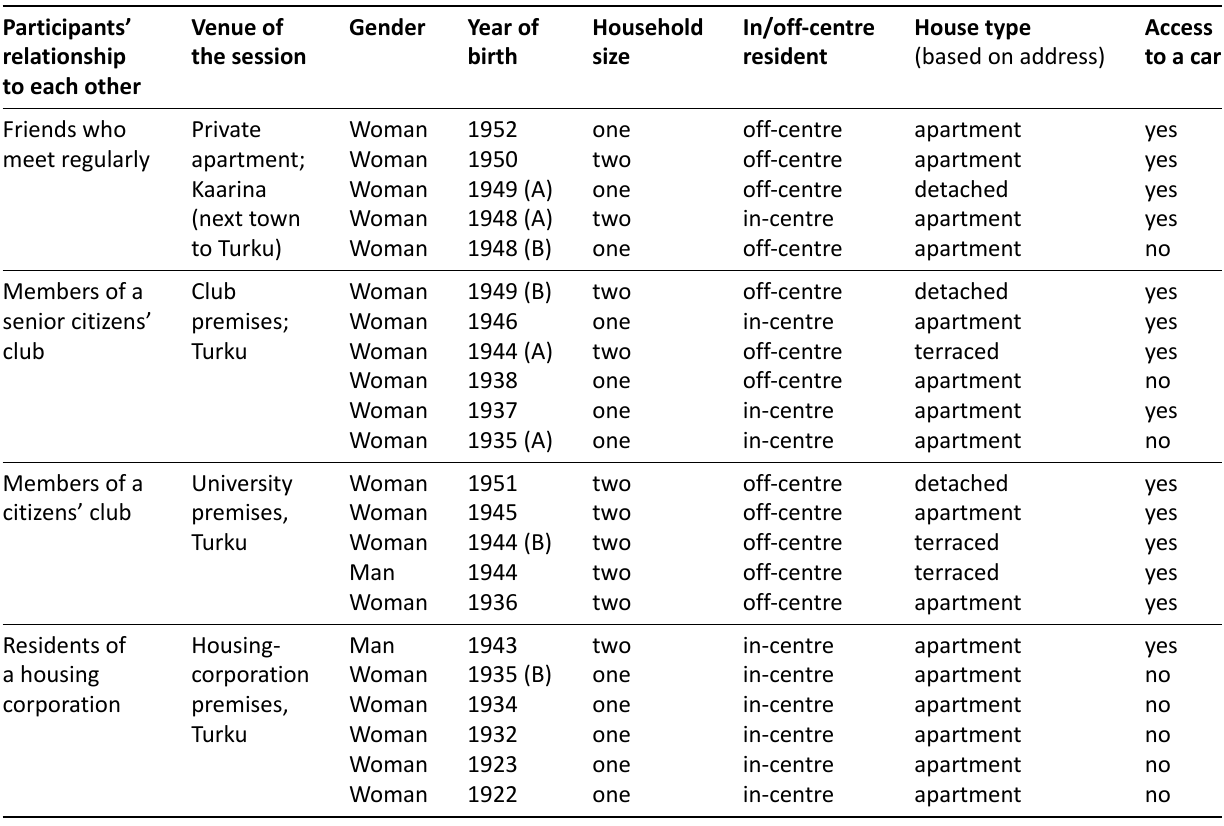
Table 1. Background information on the focus-group participants.